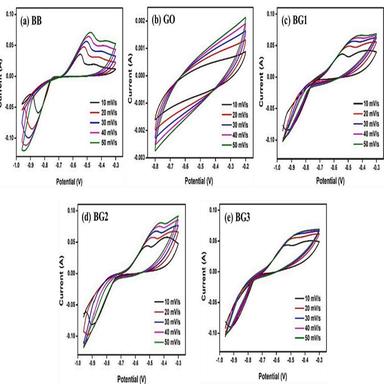
CV curves at different scan rates for (a) BB (b) GO (c) BG1 (d) BG2 and (e) BG3 electrodes.